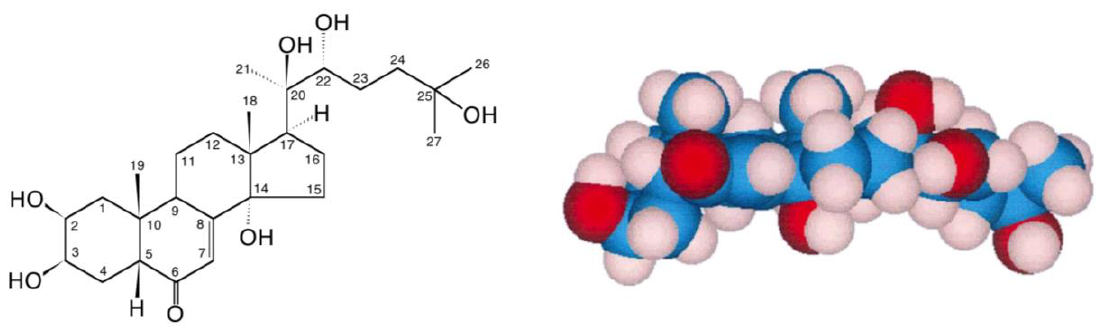
Figure 1. 20-hydroxyecdysone (20E; β -ecdysone; crustecdysone; ecdysterone; BIO101; CAS 5289-74-7; IUPAC 2 β ,3 β ,14 α ,20 R ,22 R ,25-hexahydroxy-5 β -cholest-7-en-6-one).